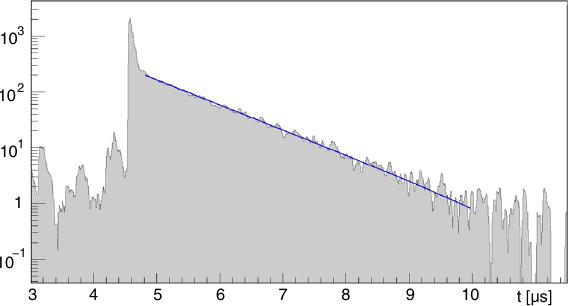
Fig. 24 Average PMT waveform recorded on 30.09.2015 in the LAr of the Gerda cryostat. The solid line indicates the triplet lifetime fit with a decay time of 0 . 97 µ s [26]